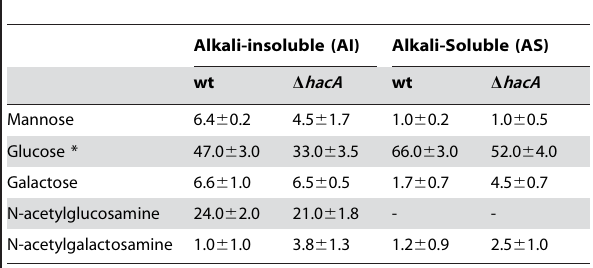
Table 1. Monosaccharide composition of the alkali-insoluble and alkali-soluble fractions of the cell wall from the wt and D hacA strains